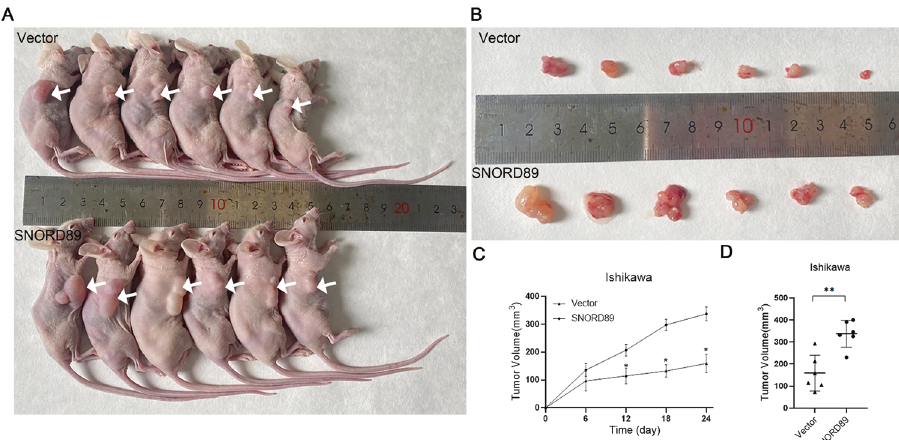
Fig. 3 Effect of SNORD89 overexpression on xenograft tumors in nude mice. A – C Tumorigenicity was greater in mice injected with the SNORD89 -overexpressing cells than in vector; D The tumor volume was greater ( n = 6). Values are presented as the mean ± SD. * p ≤ 0.05; ** p ≤ 0.01; *** p ≤